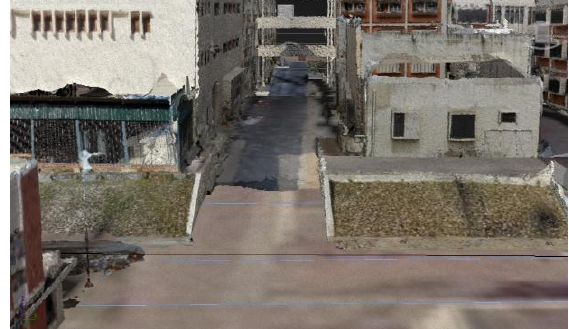
Figure 19: 3D model of civil engineering department (Another view)